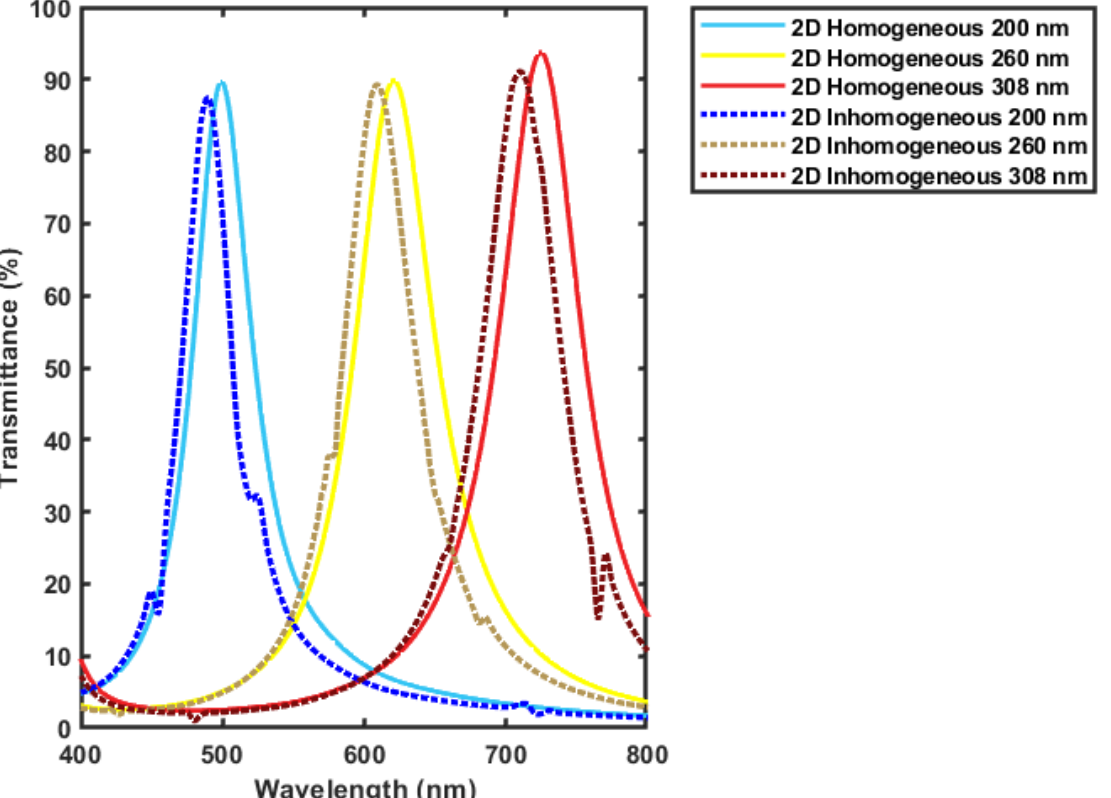
Figure 8. Comparing the transmission spectra of the filter optimized for maximum transmission with and without lateral in homogeneity in the layers’ thicknesses.